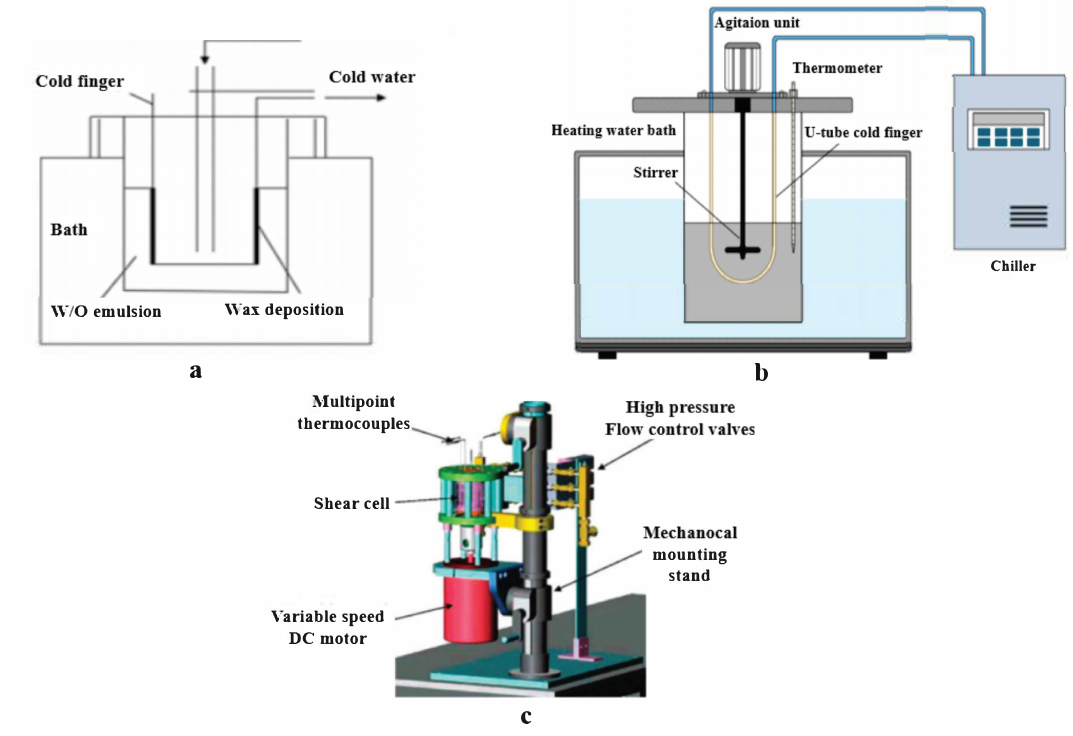
Figure 5. The schematic diagram cold finger apparatus. ( a ) static cold finger apparatus; ( b ) dynamic cold finger apparatus and ( c ) optimized dynamic cold finger apparatus